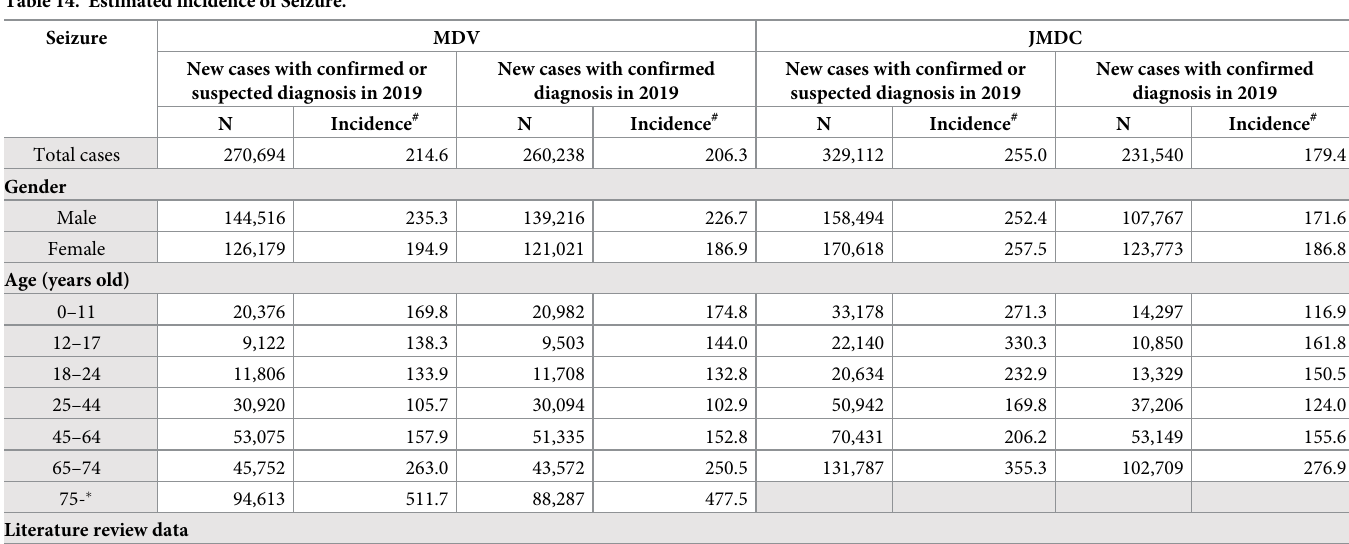
Table 14. Estimated incidence of Seizure.